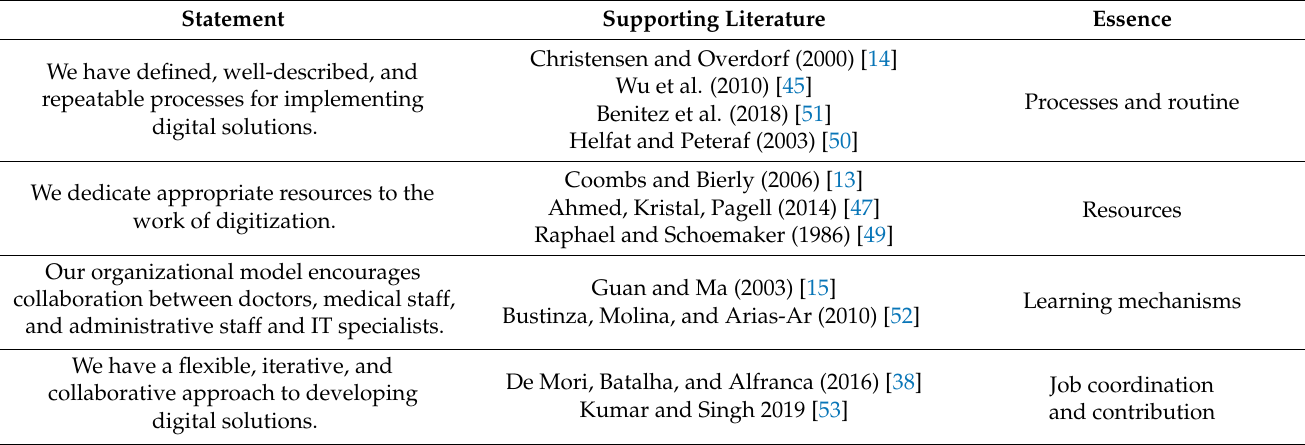
Table 2. Statements used to assess OC with supporting